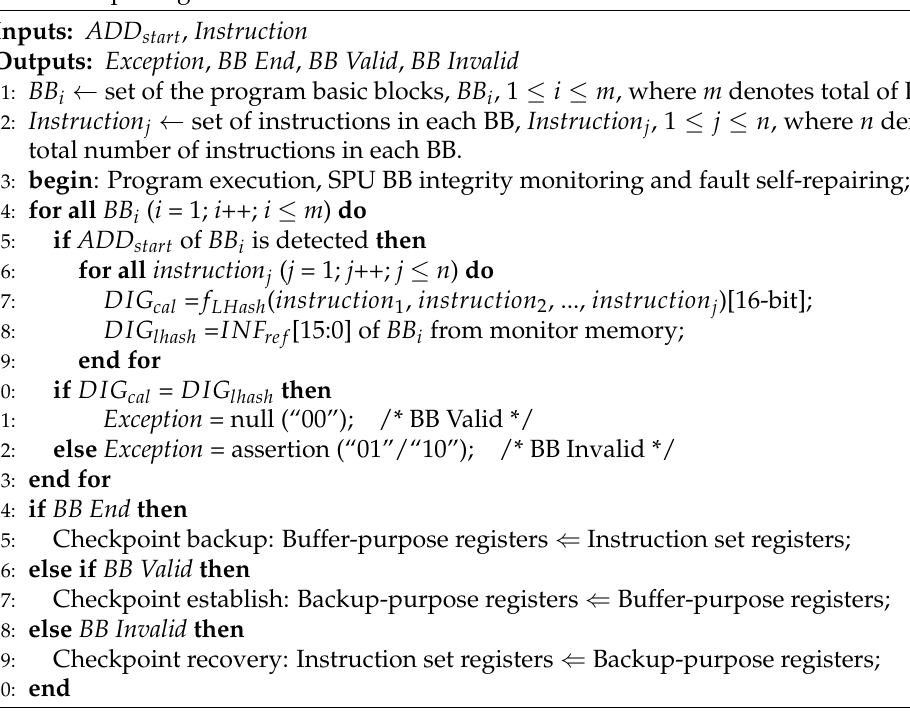
Figure 8. The hardware implementation of two-stage registers for checkpoint rollback. Algorithm 1 Implementation flow of the program execution monitoring and instruction fault